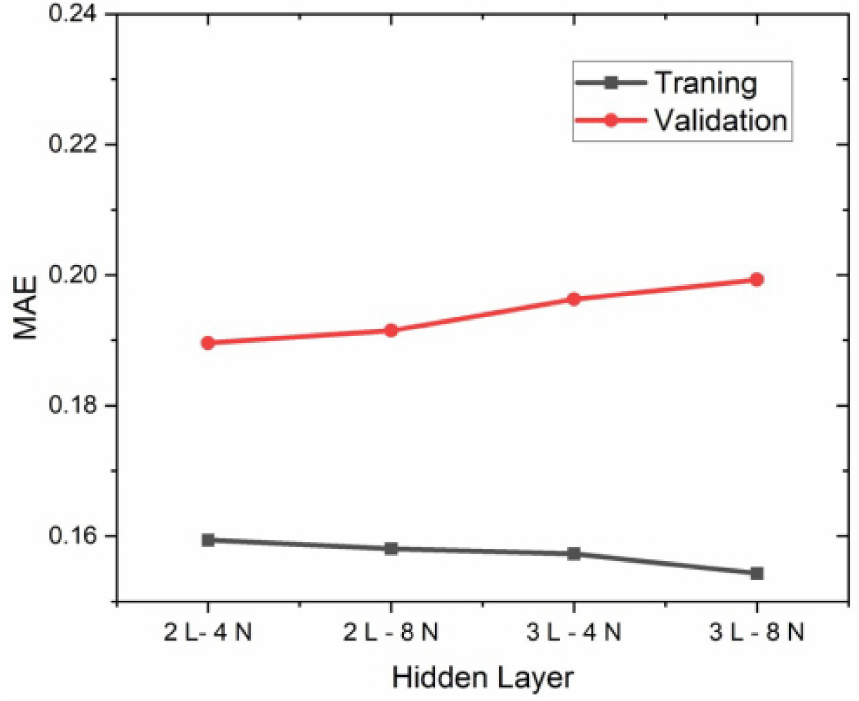
Figure 9. Results of training MSE and validation MAE according to the condition of the number of nodes in the hidden